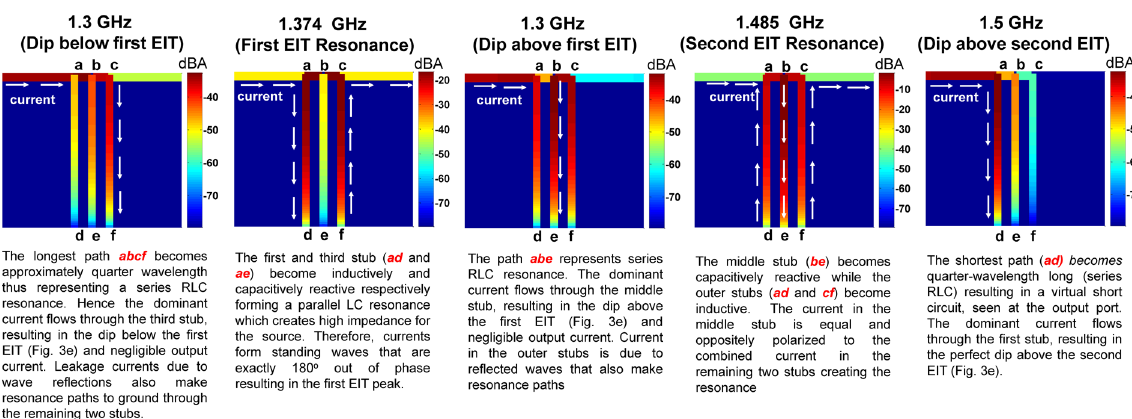
Figure 10. The resonance mechanism in the three-stub EIT structure is explained by plotting the current magnitude distributions at different frequencies corresponding to the dips and peaks of the transmission